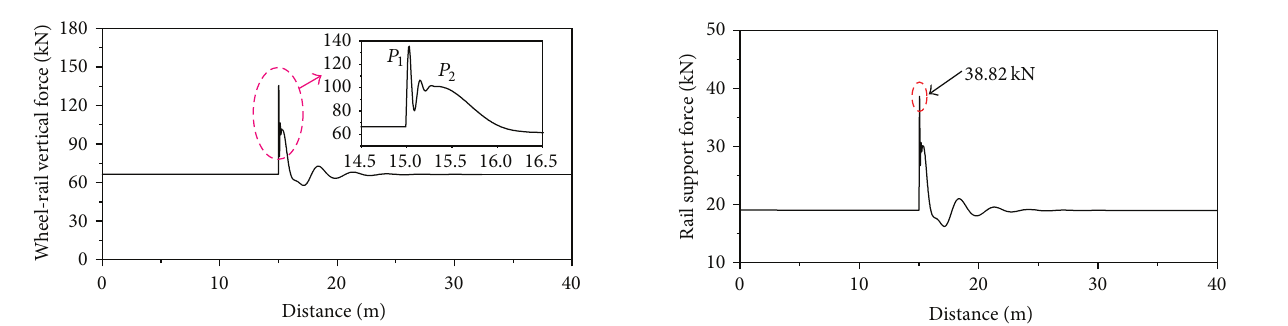
Due to the excitation of the spalling with a length of 30 mm and a depth of 1 mm, the effect of the wheel radius on the maximum value of the wheel-rail vertical force at a speed